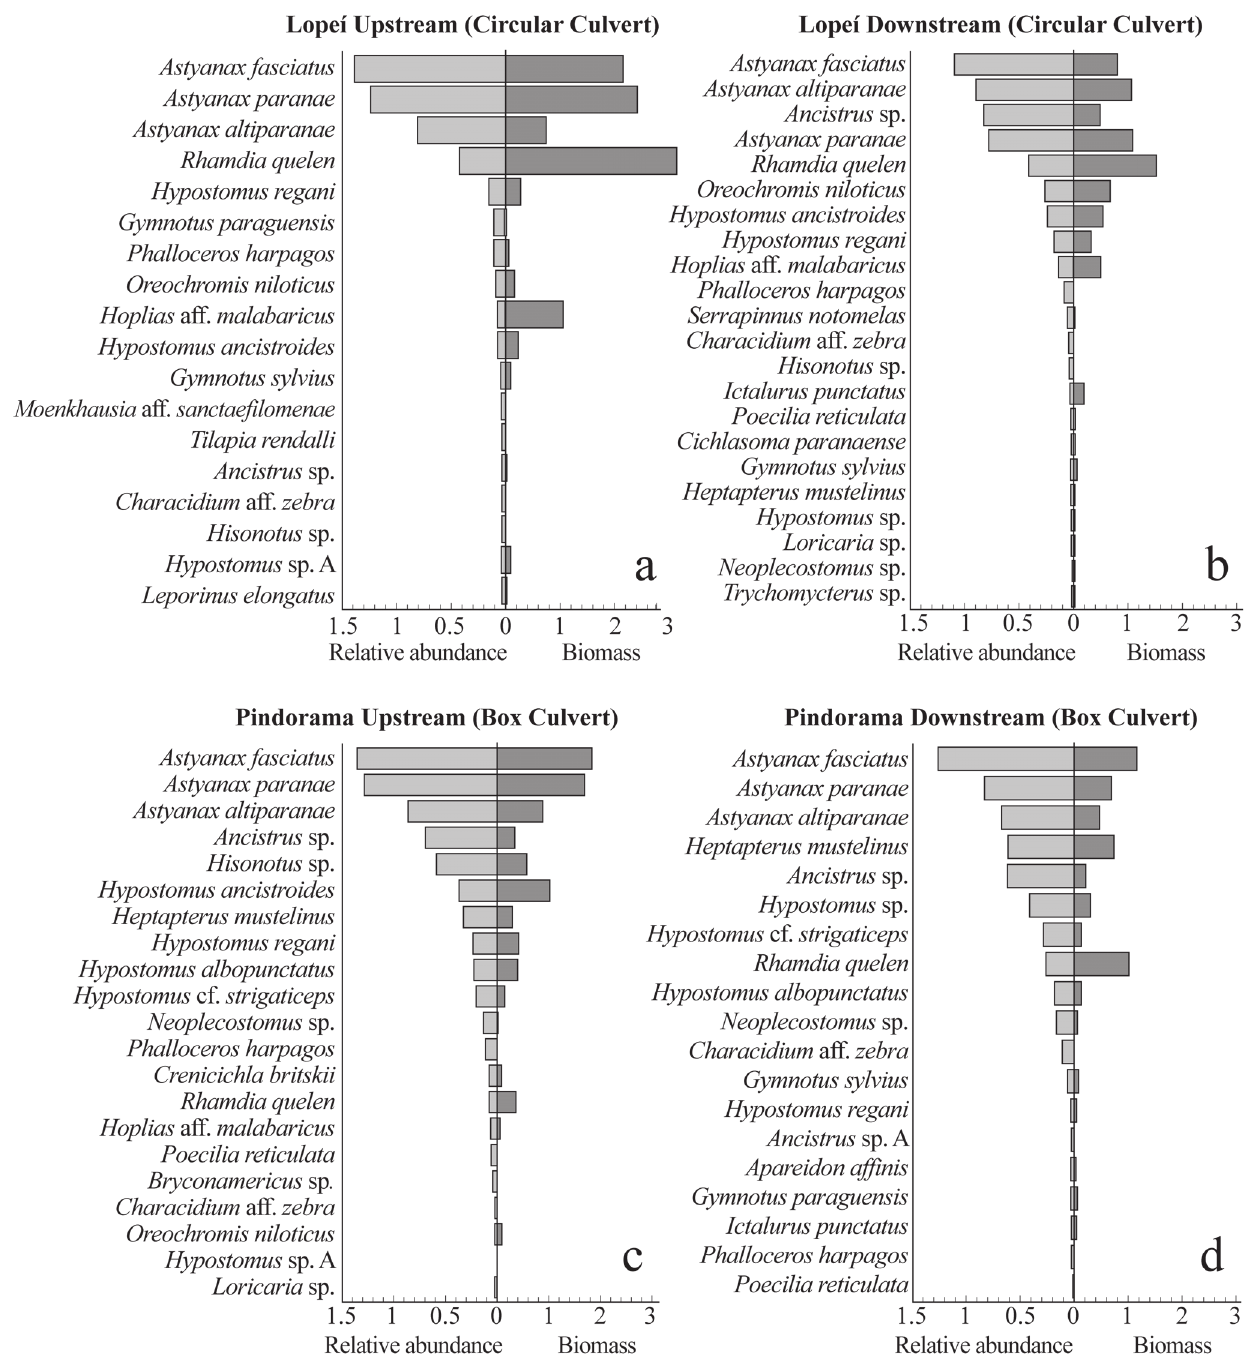
Fig 7. Relative abundance and biomass (square-root transformed) of fish species in the sampled stretches of the Lopeí stream - circular culvert ( a - b ) and Pindorama stream - box culvert ( c - d